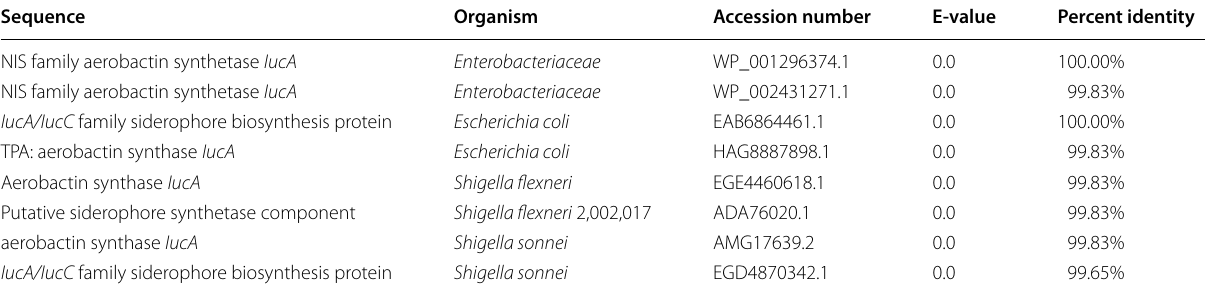
Table 5 The microorganisms showing similar sequences to the second siderophore biosynthetic gene in E. coli VR50 Sequence